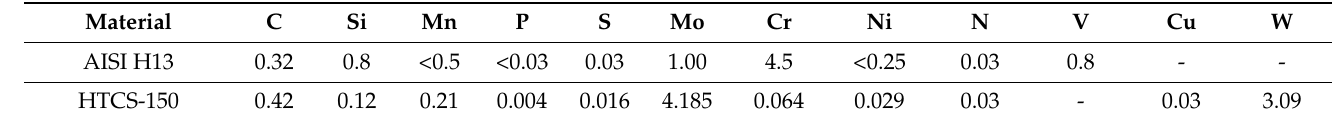
Figure 1. Scanning electron microscope (SEM) image of the HTCS-150 powders and the distribution curve of the particle sizes.